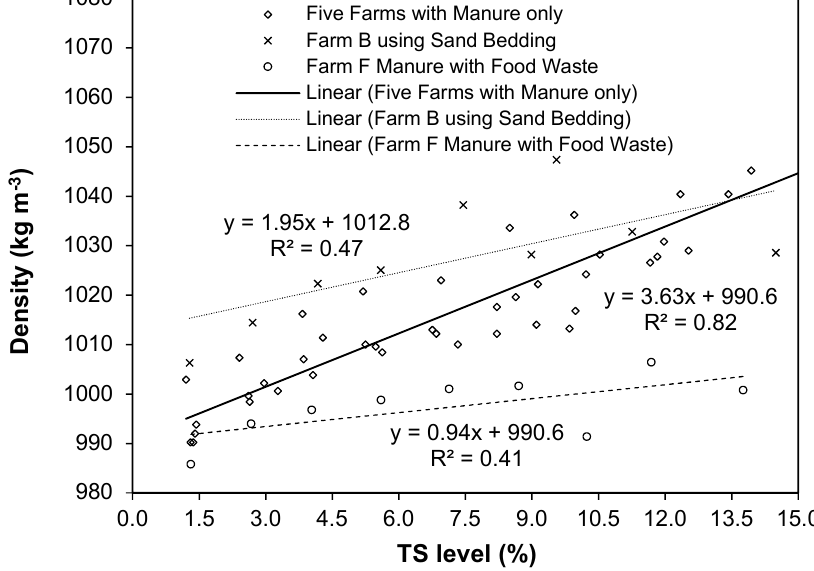
Figure 1. Density of pre-digested manure as a function of total solids (TS) content.